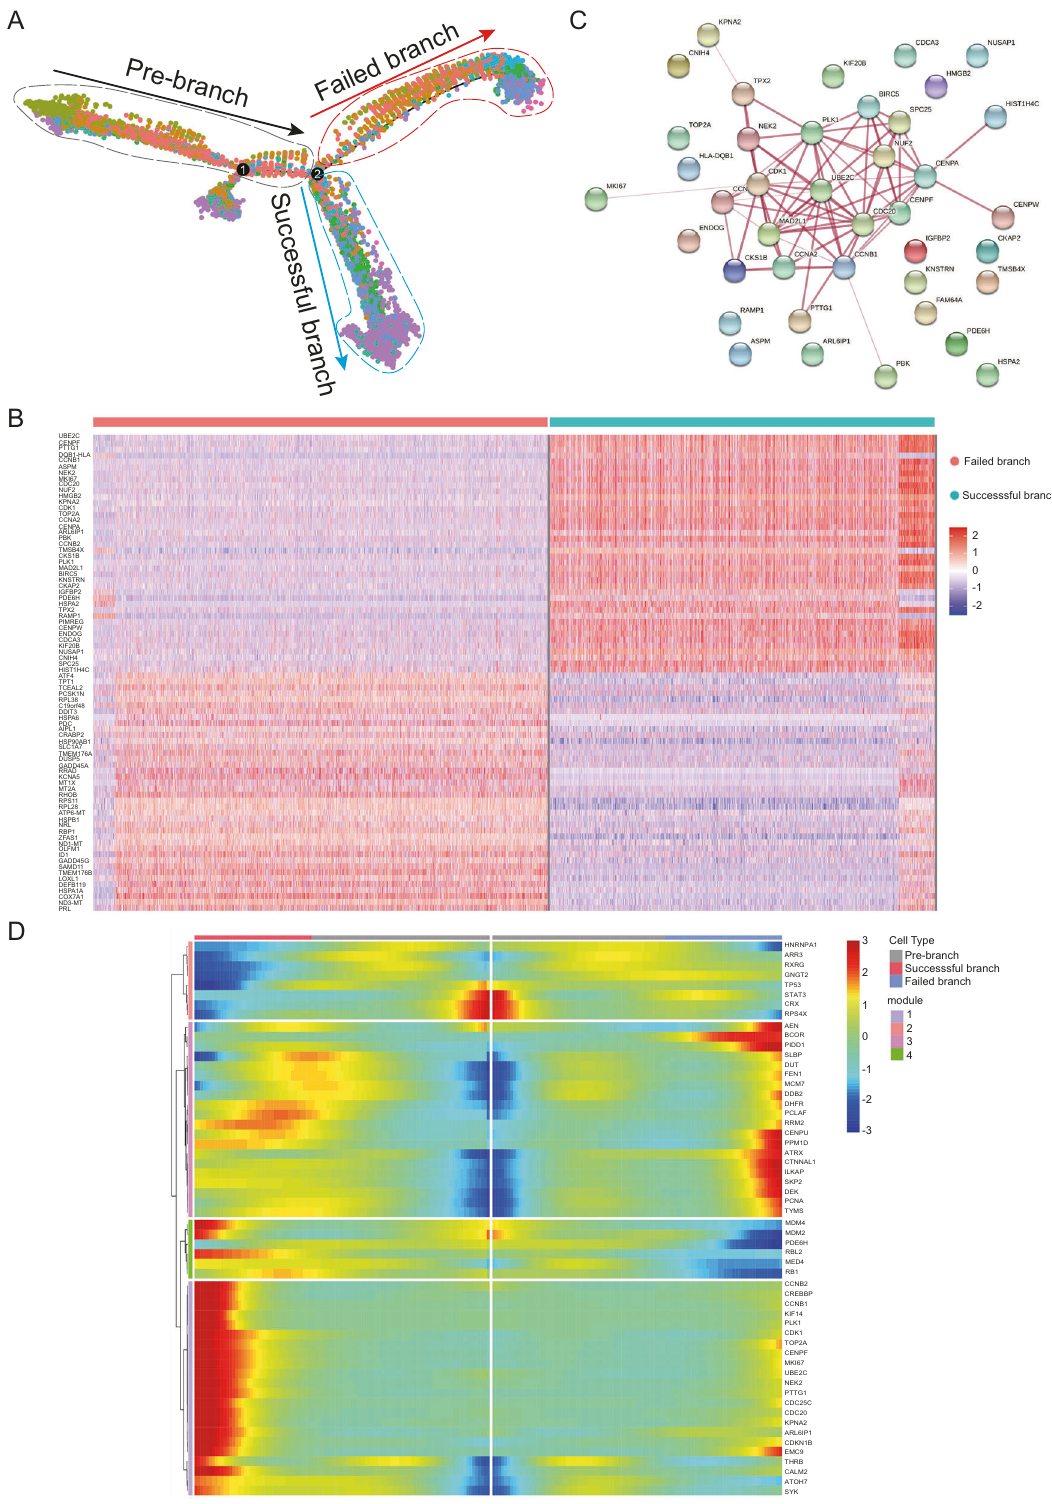
Fig. 5 Reconstruction of Reprogramming Trajectory in a Pseudotime Manner. A Trajectory reconstruction of all single cells throughout chemical reprogramming reveals three branches: pre-branch (before bifurcation), successful branch, and failed branch (after bifurcation). Blue and red circles indicate cells of the successful and failed branches, respectively. B Heatmap showing the top 40 DEGs expression levels in successful branch and failed branch cells. C Protein-protein interaction network of the top 40 DEGs in successful branch. D Heatmap showing the select genes expression dynamics during the cellular-state transition process and expression dynamics. The successful and failed branches reprogramming trajectories (including pre-branch) are shown on the right and left,